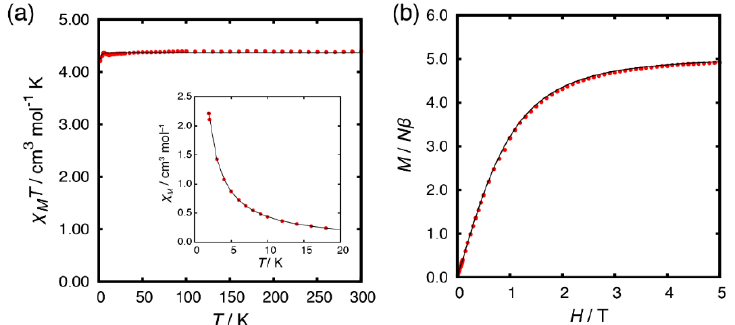
Figure 4. ( a ) Temperature dependence of the χ M T product of [Mn II {Co III ( µ -Himn) 3 }Cl 2 (CH 3 OH)] in the presence of a 0.3 T static field and an χ M vs. T plot below 20 K (inset). ( b ) Field dependence of the magnetization of [Mn II {Co III ( µ -Himn) 3 }Cl 2 (CH 3 OH)] at 1.9 K. The solid lines correspond to the fit using the PHI program. The magnetization fit is the same as fitting with a Brillouin function.